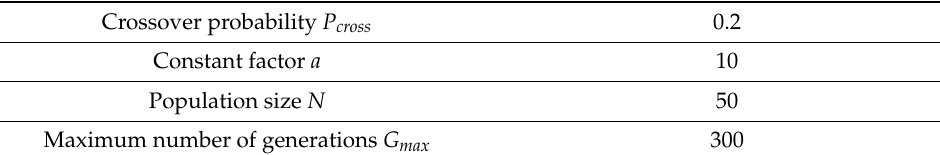
Table 2. Parameters of the D.E.